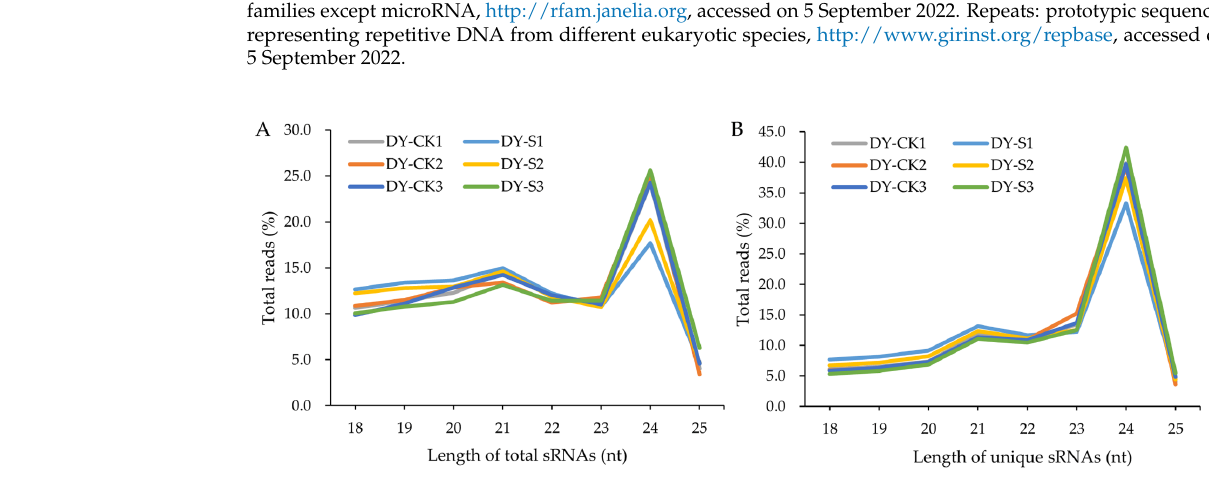
Figure 1. Length distribution and abundance of small RNAs in the libraries of DY-CK and DY-S samples. ( A ) Size distribution of total small RNAs; ( B ) Size distribution of unique small RNAs.